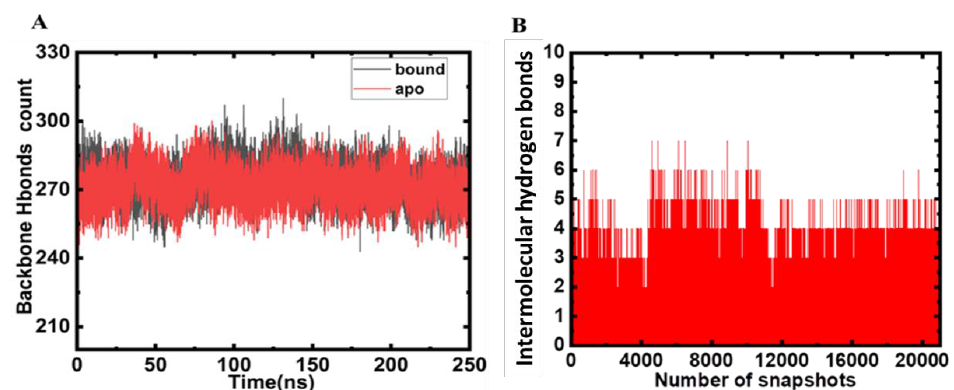
Figure 5. Hydrogen bonding. ( A ) Intramolecular hydrogen bonds (both apo and Mtf bound MARK4) plotted as a function of time. ( B ) The time evolution of intermolecular hydrogen bonds monitored between MARK4 and Mtf.